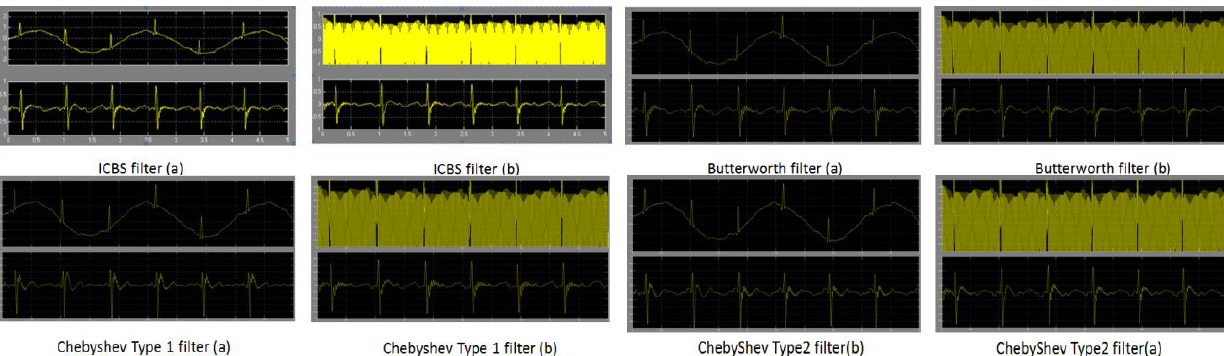
Figure 12. Simulation waveforms of our proposed ICBS filter and other state of the art filters in removing base line wander and power line interference.